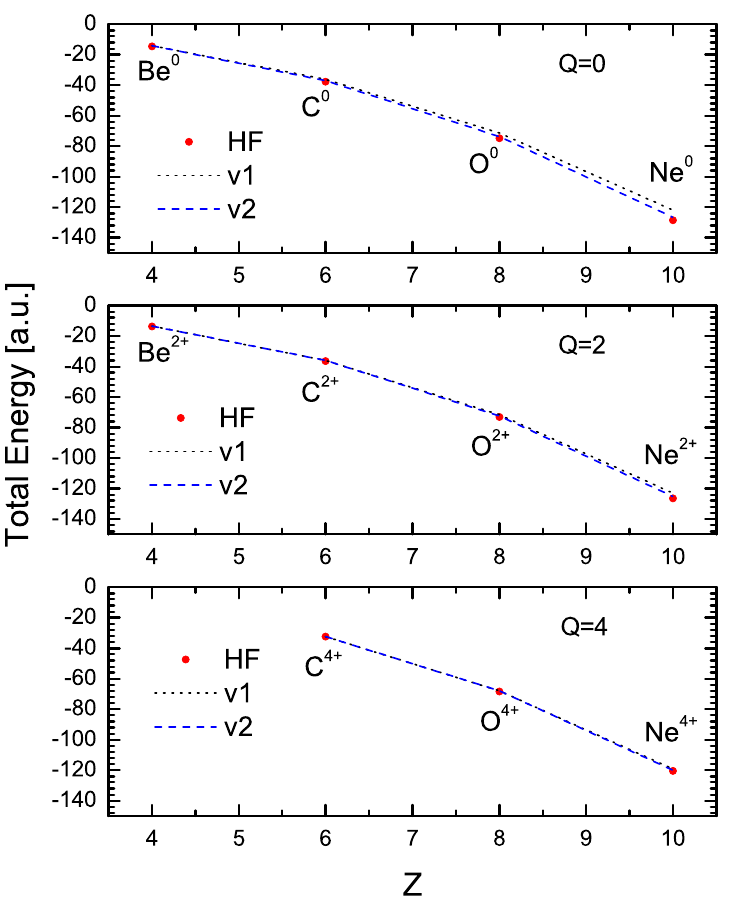
Figure 3. Comparison between energy values resulting from variational calculations using 1 and 2 parameters and those from the Hartree–Fock calculation for neutral atoms (Q = 0) and for ions with charge Q = 2 and Q =